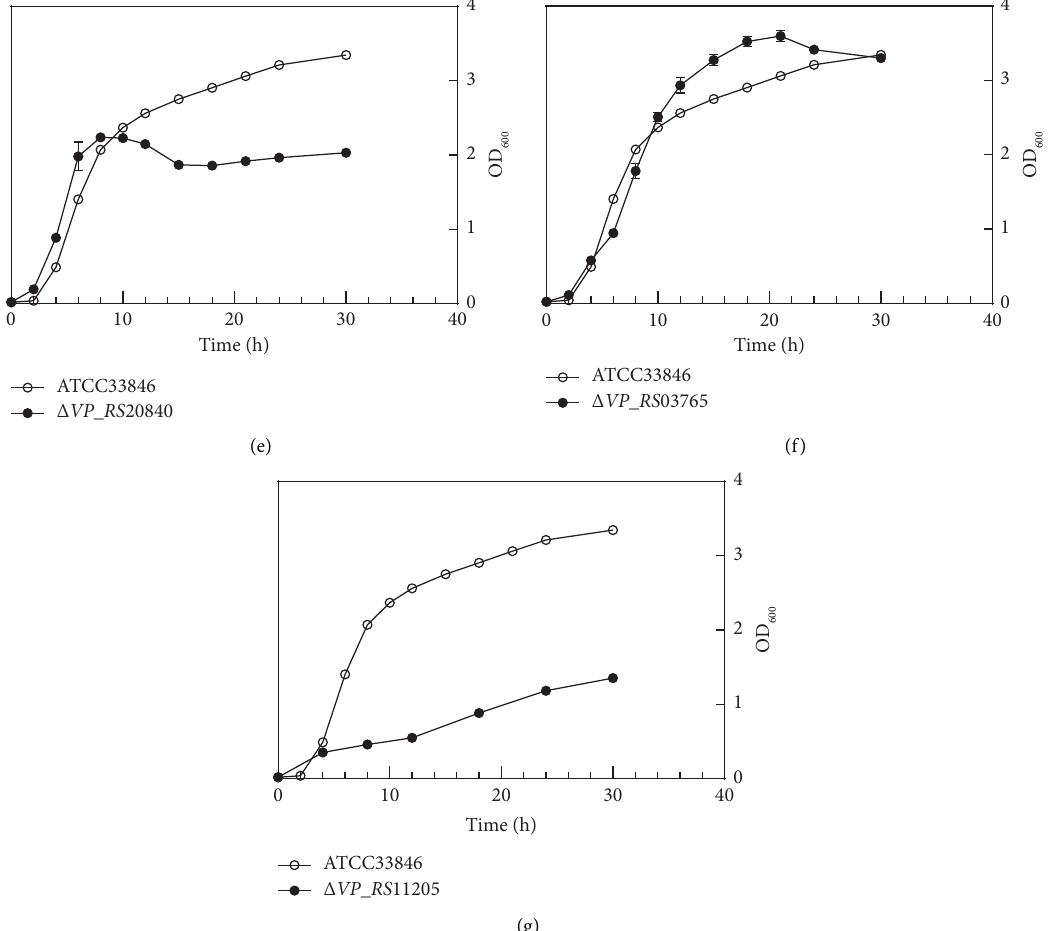
Figure 2: Growth curves of the 7 V. parahaemolyticus OMP deletion mutants. Wild-type V. parahaemolyticus ATCC33846 was used as a control. Each point represents the mean value of three biological replicates, and error bars represent standard deviations calculated from three biological